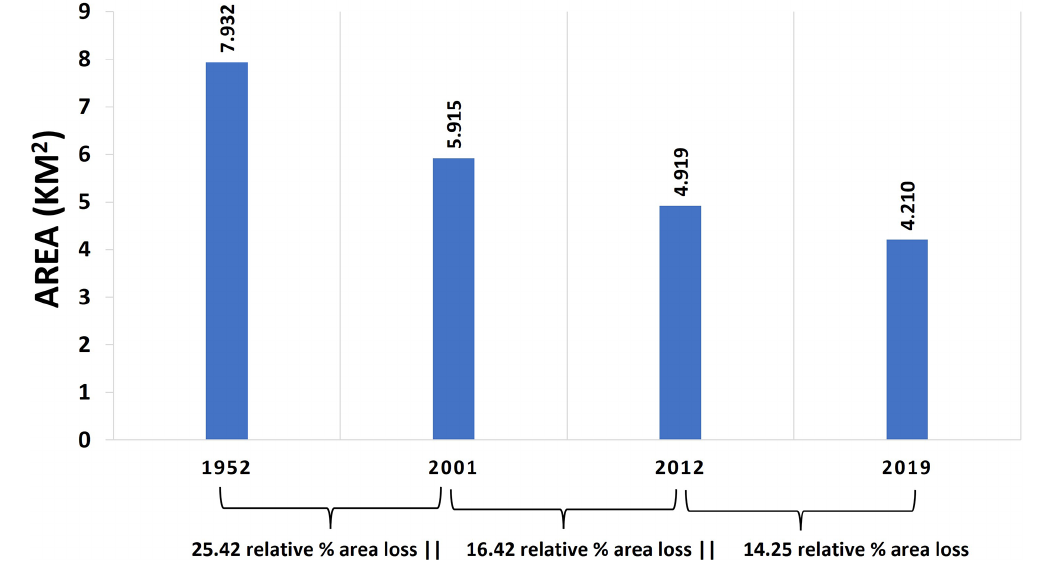
Figure 9. A comparison of the total surface area of all IAs (423 IAs) in the MBM over 67 years.